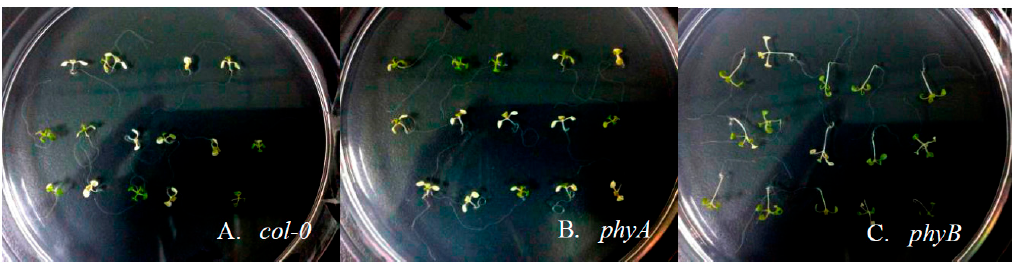
Figure 4. Survival analysis of different Arabidopsis genotypes under HS treatment. After treatment at 37 °C for three days, about 44% and 40% col-0 and phyA seedlings still survive (see ( A , B )); However, the survival rate of phyB is more than 70% (see ( C )).